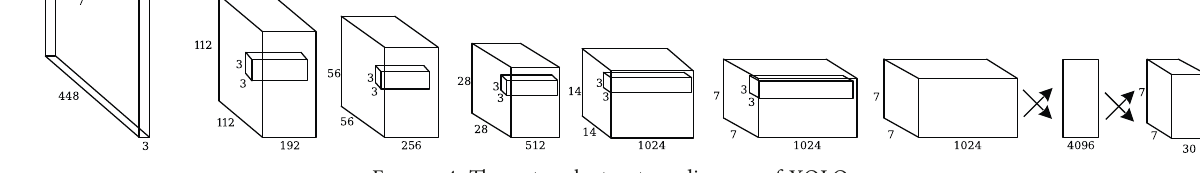
Figure 4: The network structure diagram of YOLO.